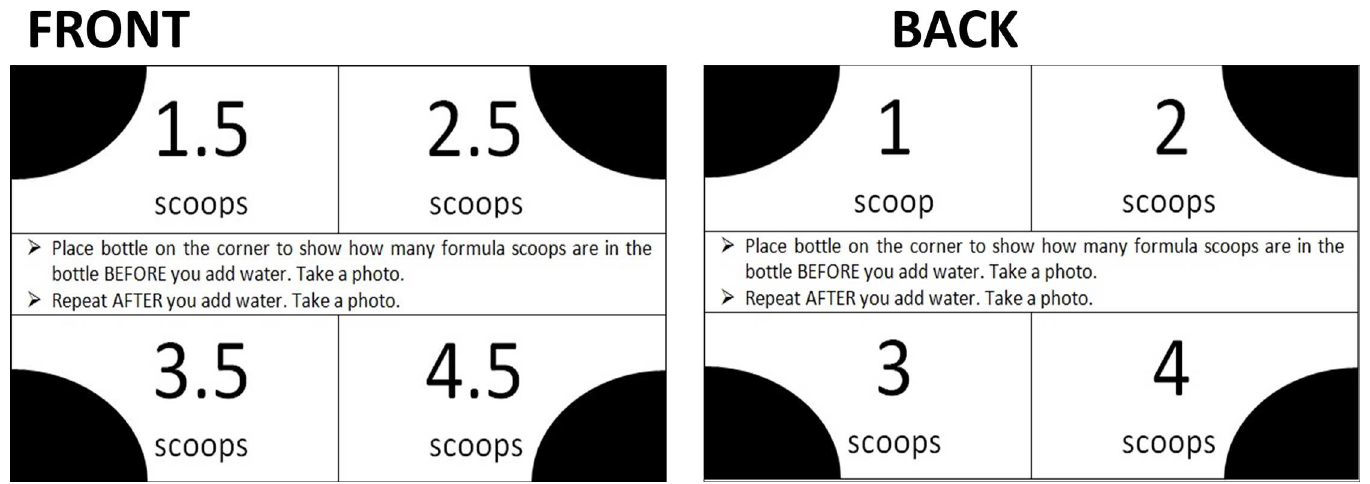
Fig 1. RFPM Infant Powdered Formula Standard